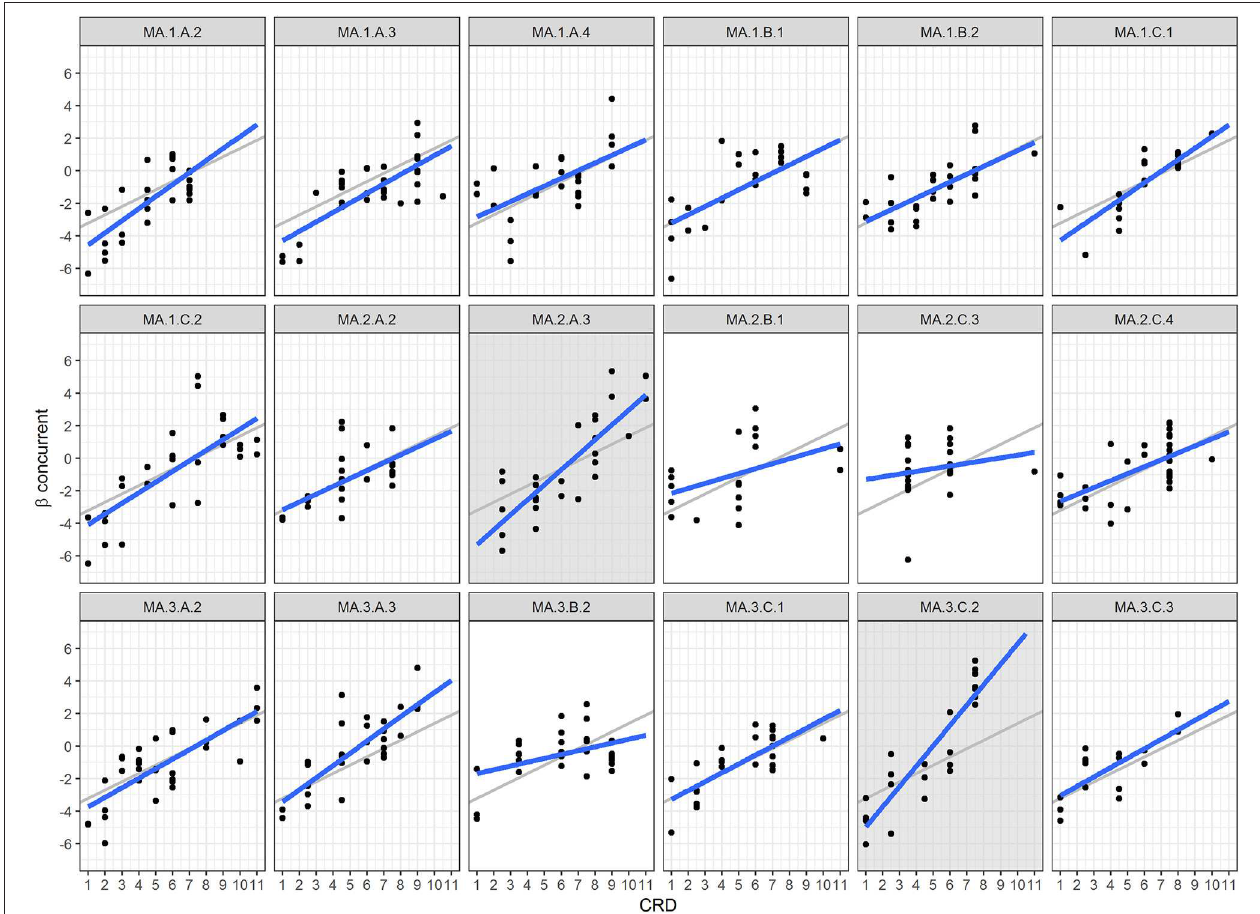
FIGURE 5 | Relationship between difficulty estimates and CRD and related regression lines by competency. Bold blue lines = regression lines, gray lines = regression line of competency MA.1.B.1, white background = competencies with insignificant correlations, and gray background = competencies with significant interaction